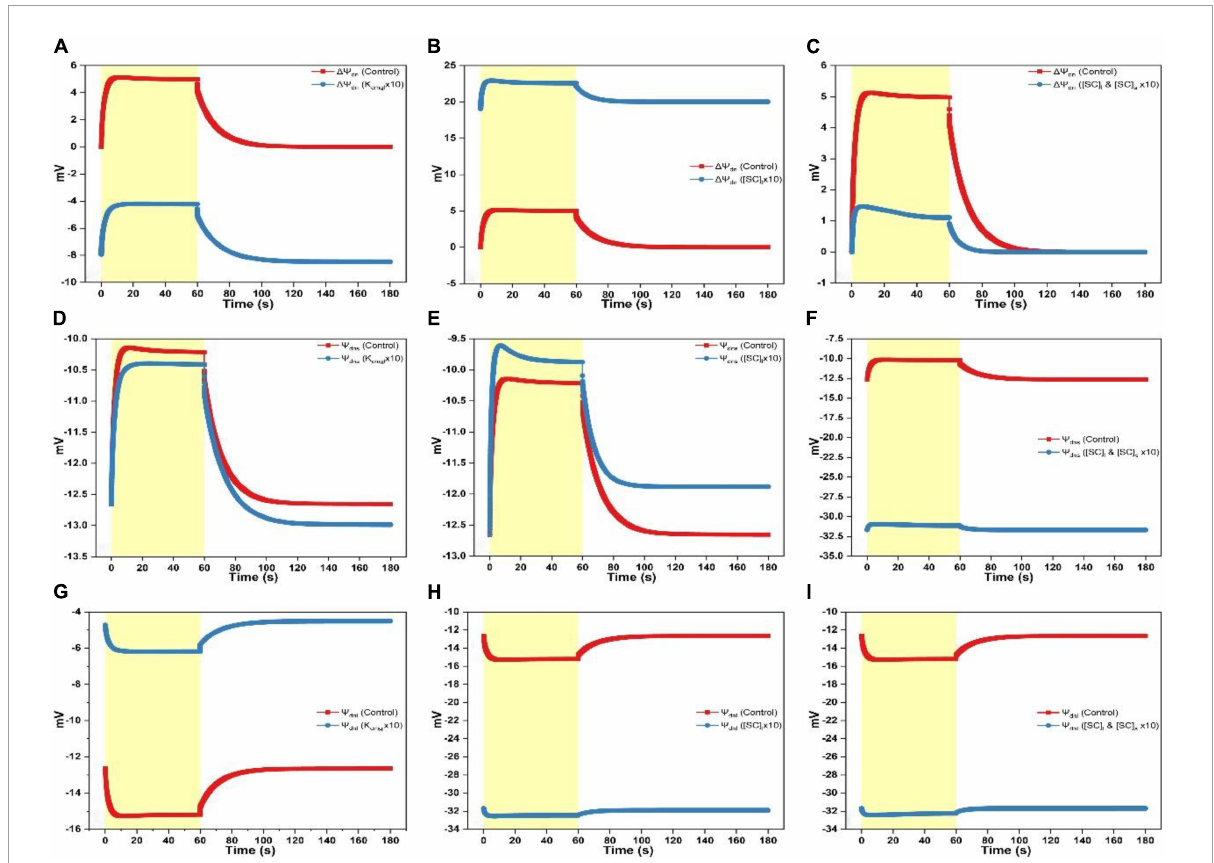
FIGURE5 Simulated responses of (cid:57) dnl , (cid:57) dns , and (cid:49)(cid:57) dn on assigning different values for adjustable parameters. (A) Simulated responses of (cid:49)(cid:57) dn by adjusting K cmgl 1- and 10-fold of the controlled value. (B) Simulated responses of (cid:49)(cid:57) dn by adjusting [SC] l 1- and 10-fold of the controlled value. (C) Simulated responses of (cid:49)(cid:57) dn by adjusting [SC] l and [SC] s 1- and 10-fold of the controlled value. (D) Simulated responses of (cid:57) dns by adjusting K cmgl 1- and 10-fold of the controlled value. (E) Simulated responses of (cid:57) dns by adjusting [SC] l 1- and 10-fold of the controlled value. (F) Simulated responses of (cid:57) dns by adjusting [SC] l and [SC] s 1- and 10-fold of the controlled value. (G) Simulated responses of (cid:57) dnl by adjusting K cmgl 1- and 10-fold of the controlled value. (H) Simulated responses of (cid:57) dnl by adjusting [SC] l 1- and 10-fold of the controlled value. (I) Simulated responses of (cid:57) dnl by adjusting [SC] l and [SC] s 1- and 10-fold of the controlled value.